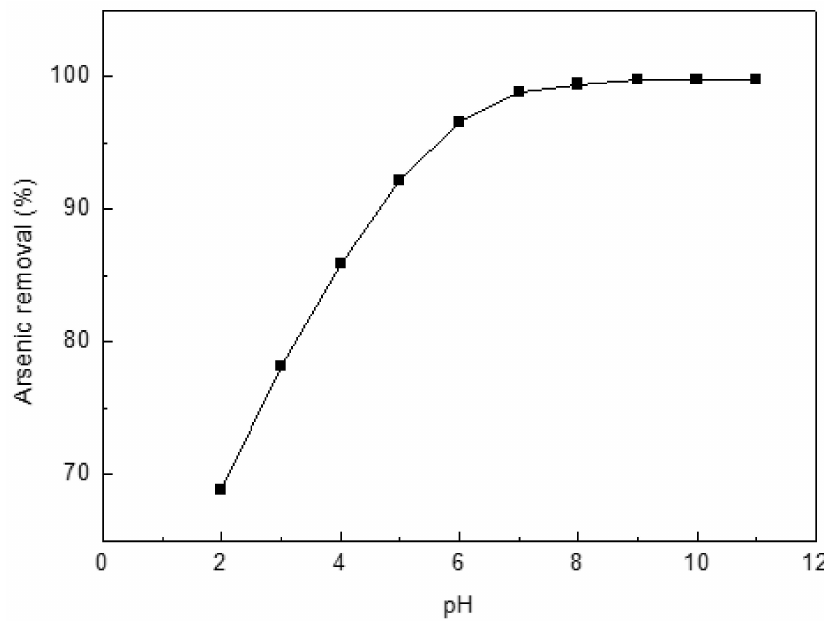
Figure 5. Effect of pH on the adsorption of arsenic on char. Initial arsenic concentration: 10 mg/L; char: 0.4 g/L; temperature: 25 ◦ C; equilibration time: 12